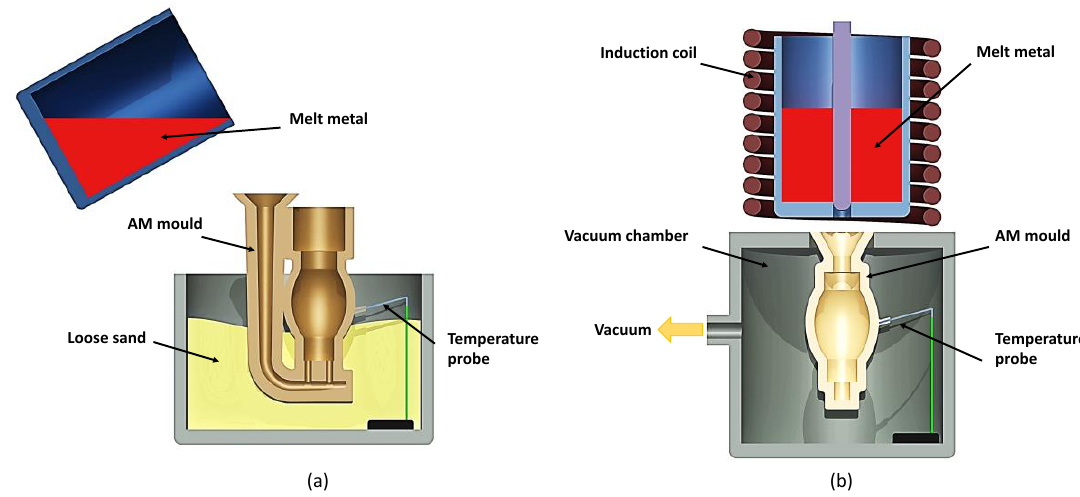
Figure 4. Diagram of the casting process: ( a ) gravity-pouring technique, ( b ) vacuum-assisted technique.